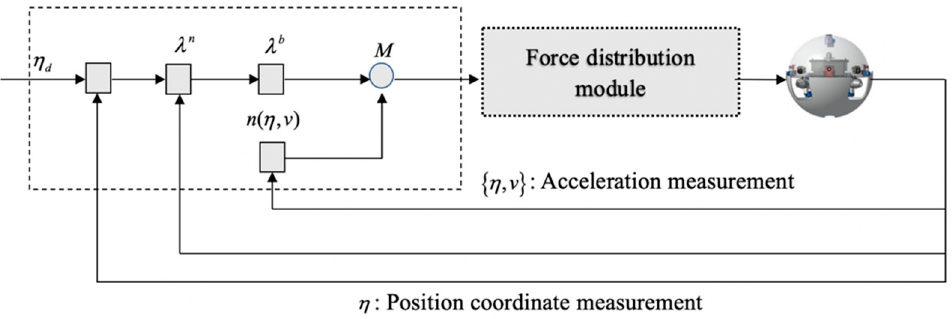
Figure 5. Aechitecture of the state feedback linearization controller.